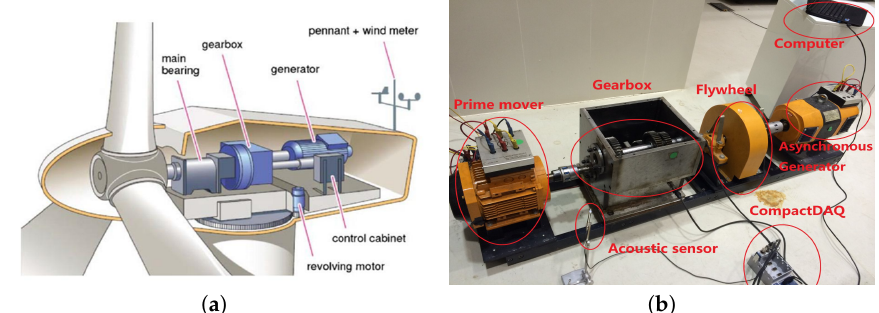
Figure 1. Diagram and fault simulator for wind turbine generator system (WTGS). ( a ) The diagram of WTGS; ( b ) the simulation platform of